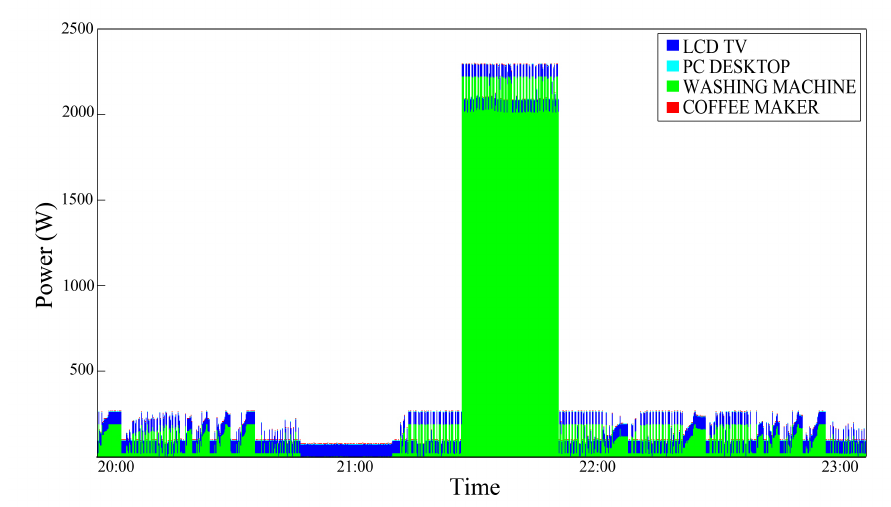
Figure 9. Aggregate power consumption trace—test case 2.